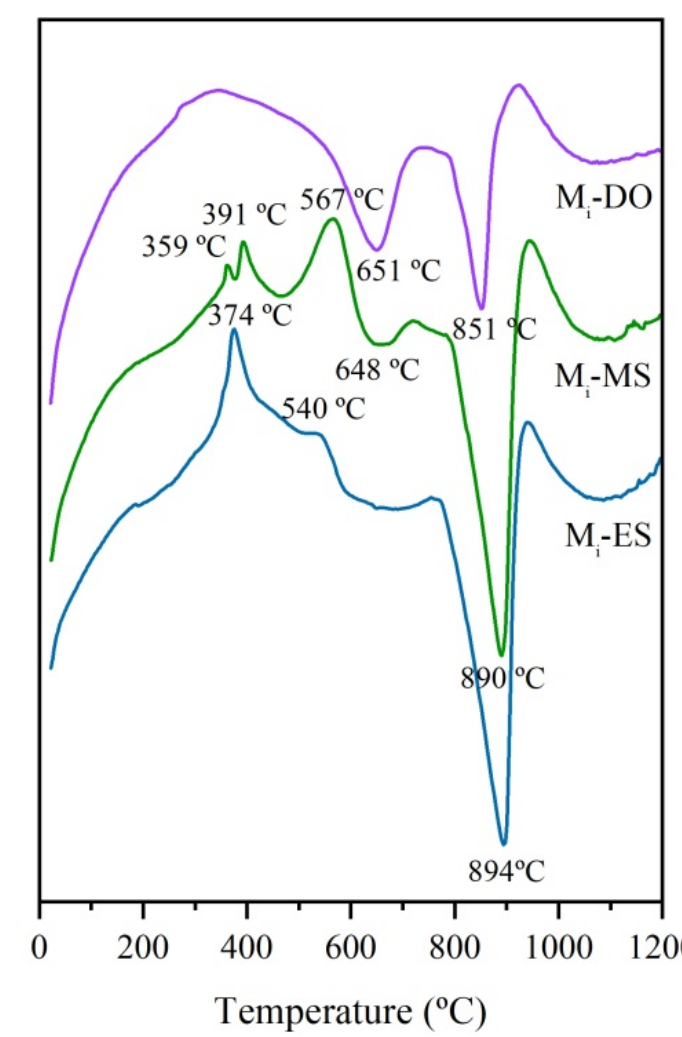
Figure 5. DTA curves of initial mixtures: M i -ES, M i -MS, and M i -DO.